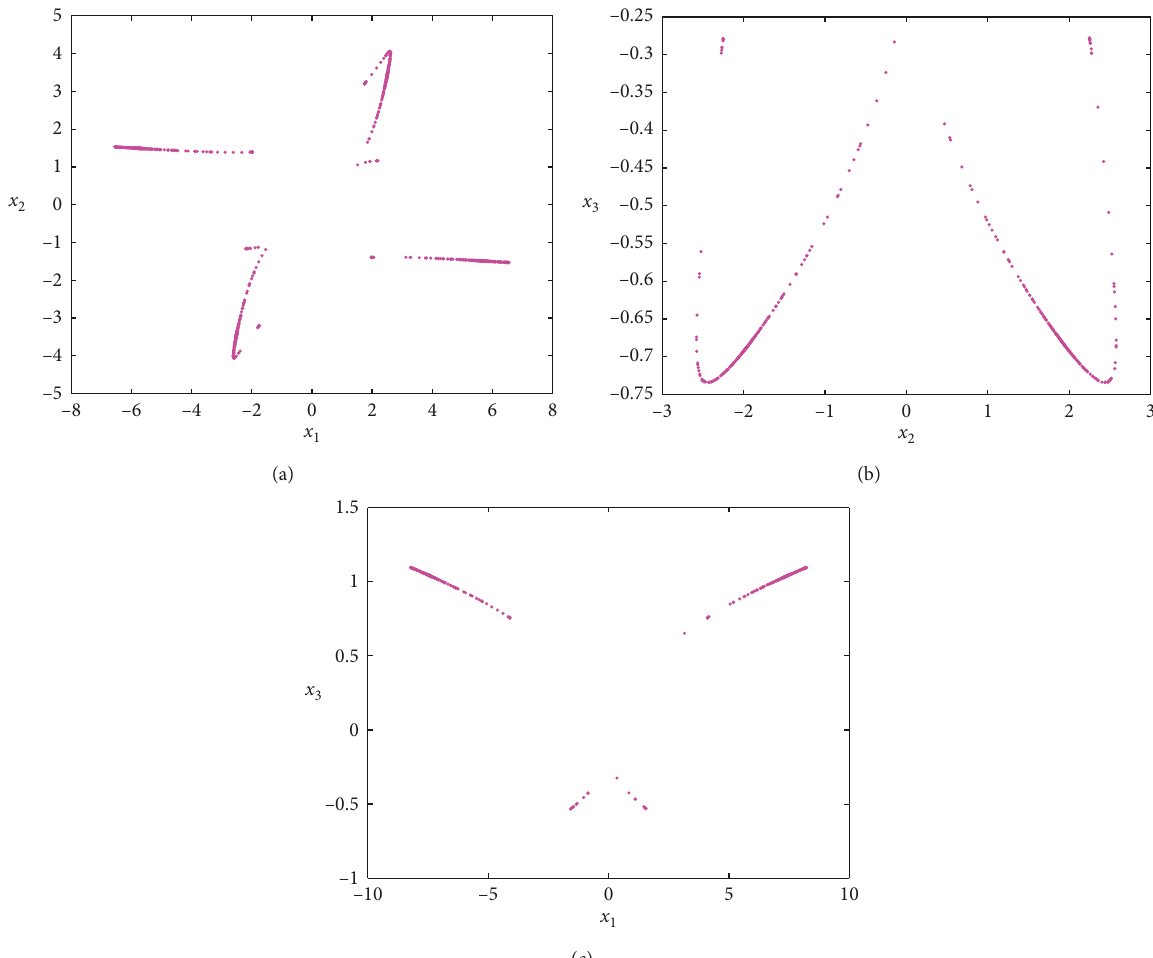
Figure 3: Poincar´e maps on the plane of (a) x